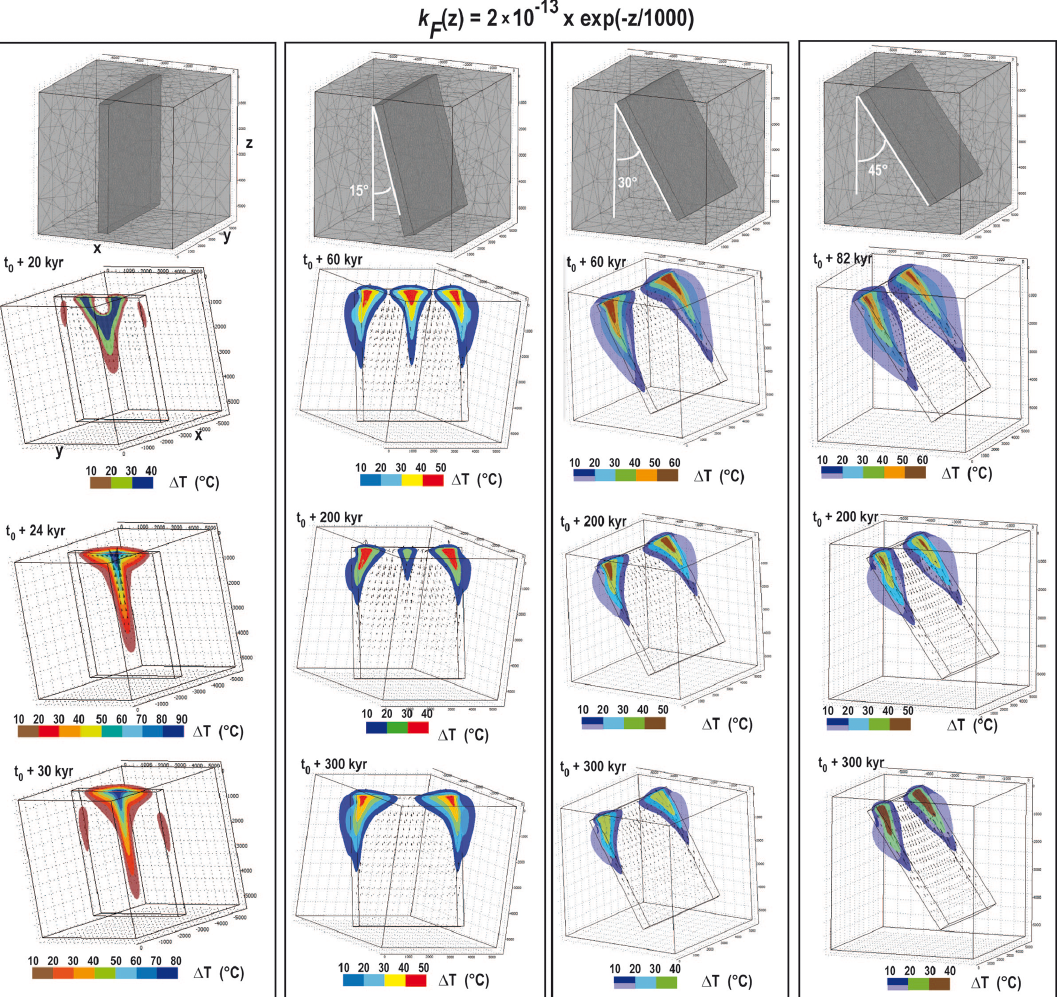
Figure 10. Four experiments with realistic fluid properties and a depth-dependent permeability with a dip angle of 0, 15, 30, and 45 ◦ . Few differences exist between the two higher dip angles. The largest temperature anomaly amplitudes are obtained in the vertical case (left) and during the first tens of thousands of years. In the second case (15 ◦ dip angle), a transient anomaly disappears after